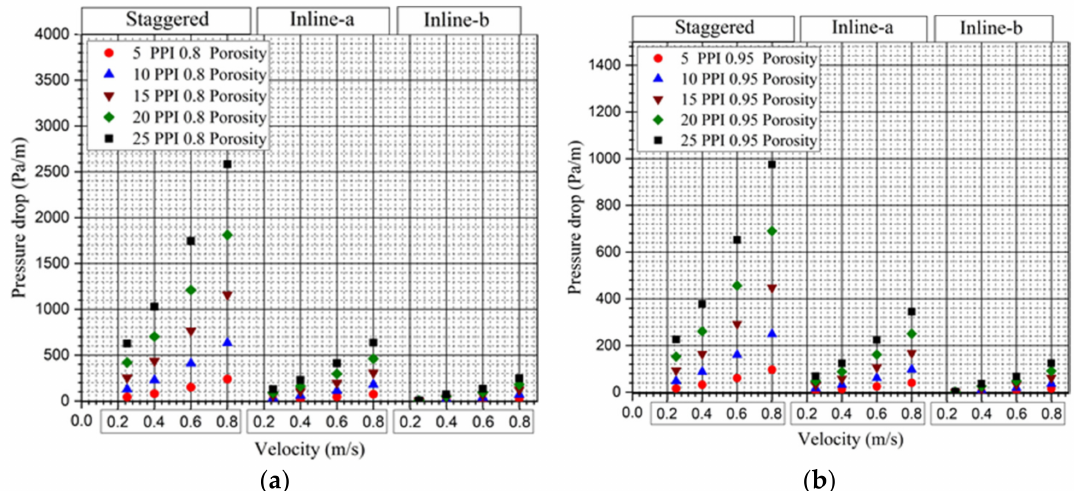
Figure 19. ( a ) Variation of pressure drop for 0.8 porosity wire mesh samples of different pore- density/mesh-size for all three stacking scenarios. ( b ) Variation of pressure drop for 0.95 porosity wire mesh samples of different pore-density/mesh-size for all three stacking